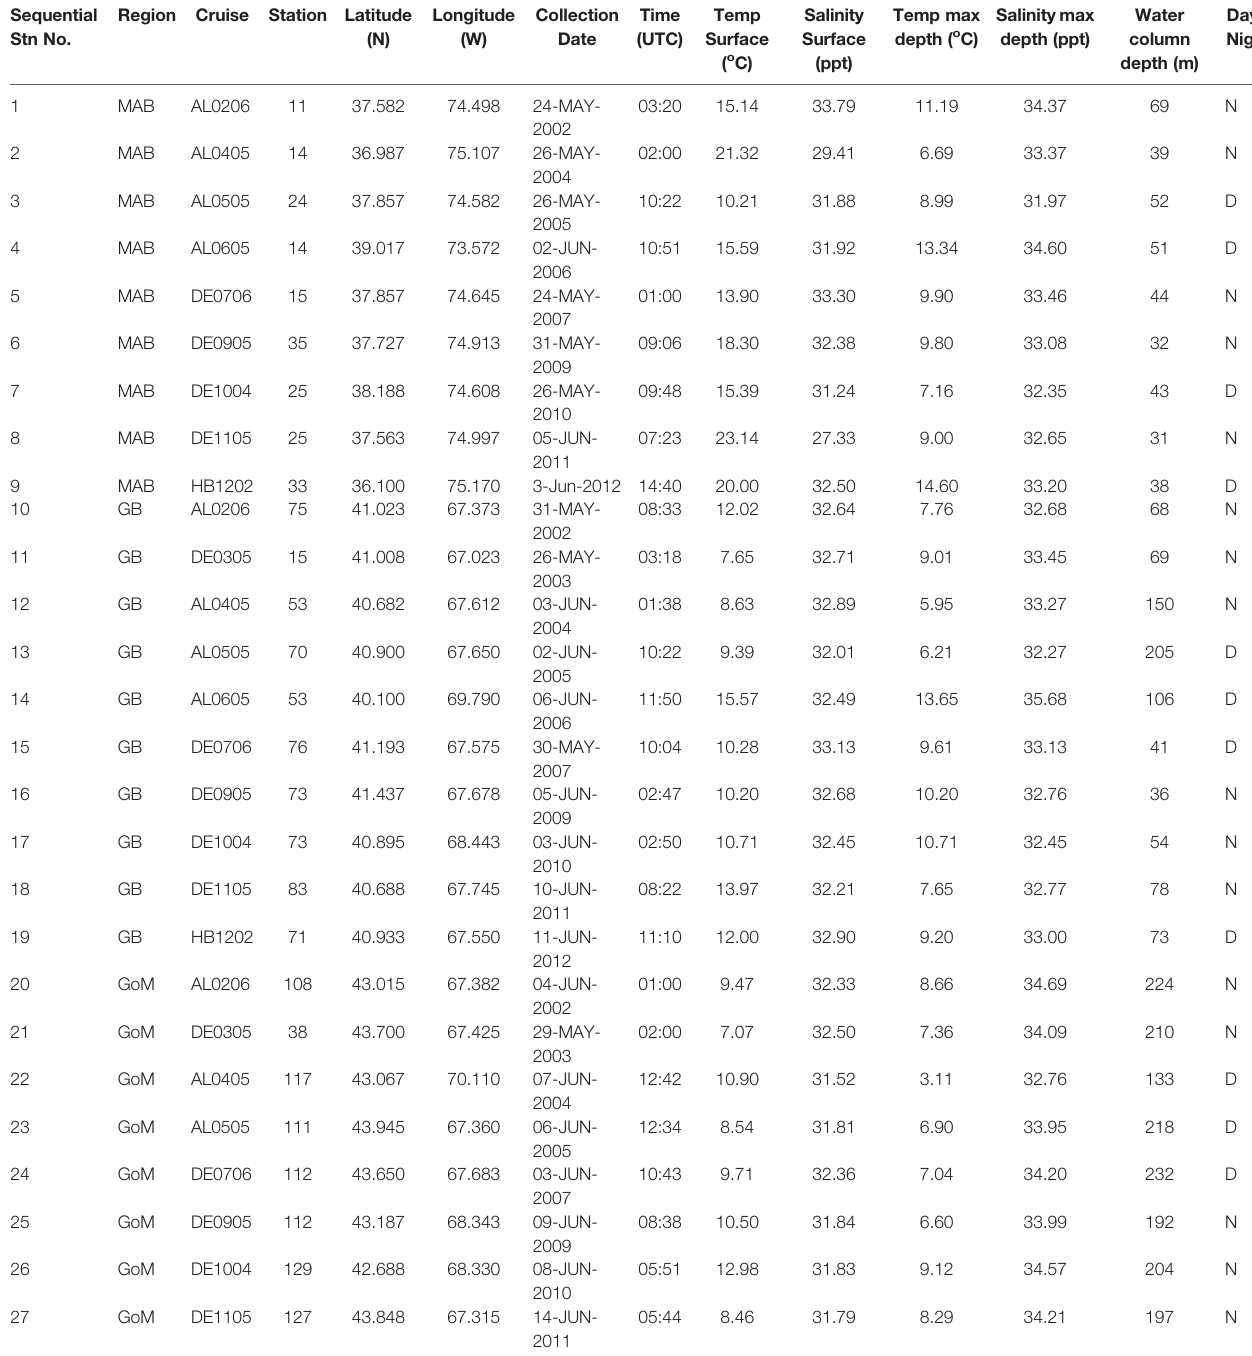
TABLE 1 | Collection locations and dates for EcoMon Survey samples analyzed. Sequential Region Cruise Station Latitude Stn No.